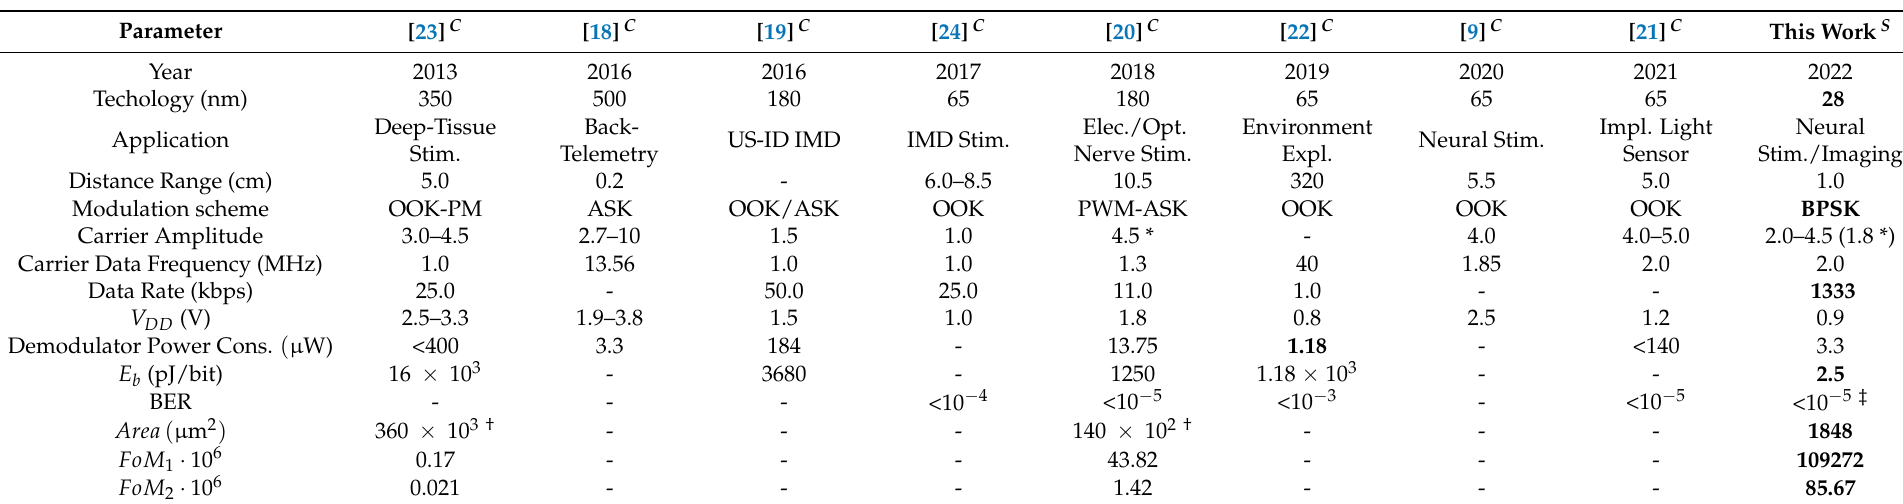
Table 6. Comparison with the